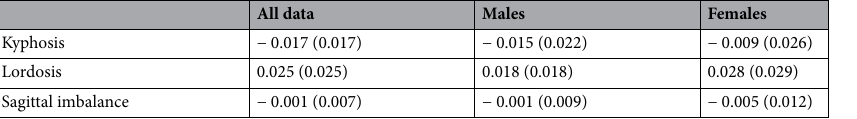
Table 3. The fixed coefficients (with standard error in brackets) of the models for a main thoracic coronal asymmetry